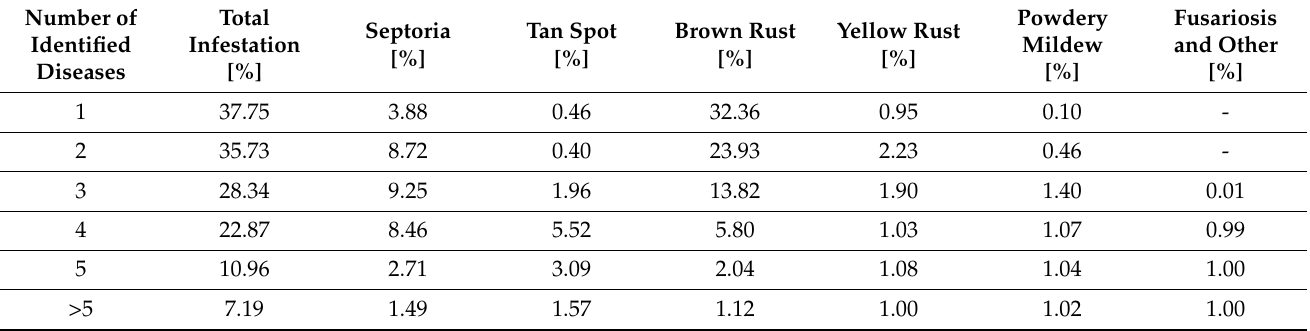
Table 10. Fungal disease infestation in relation to the number of diseases found on a single